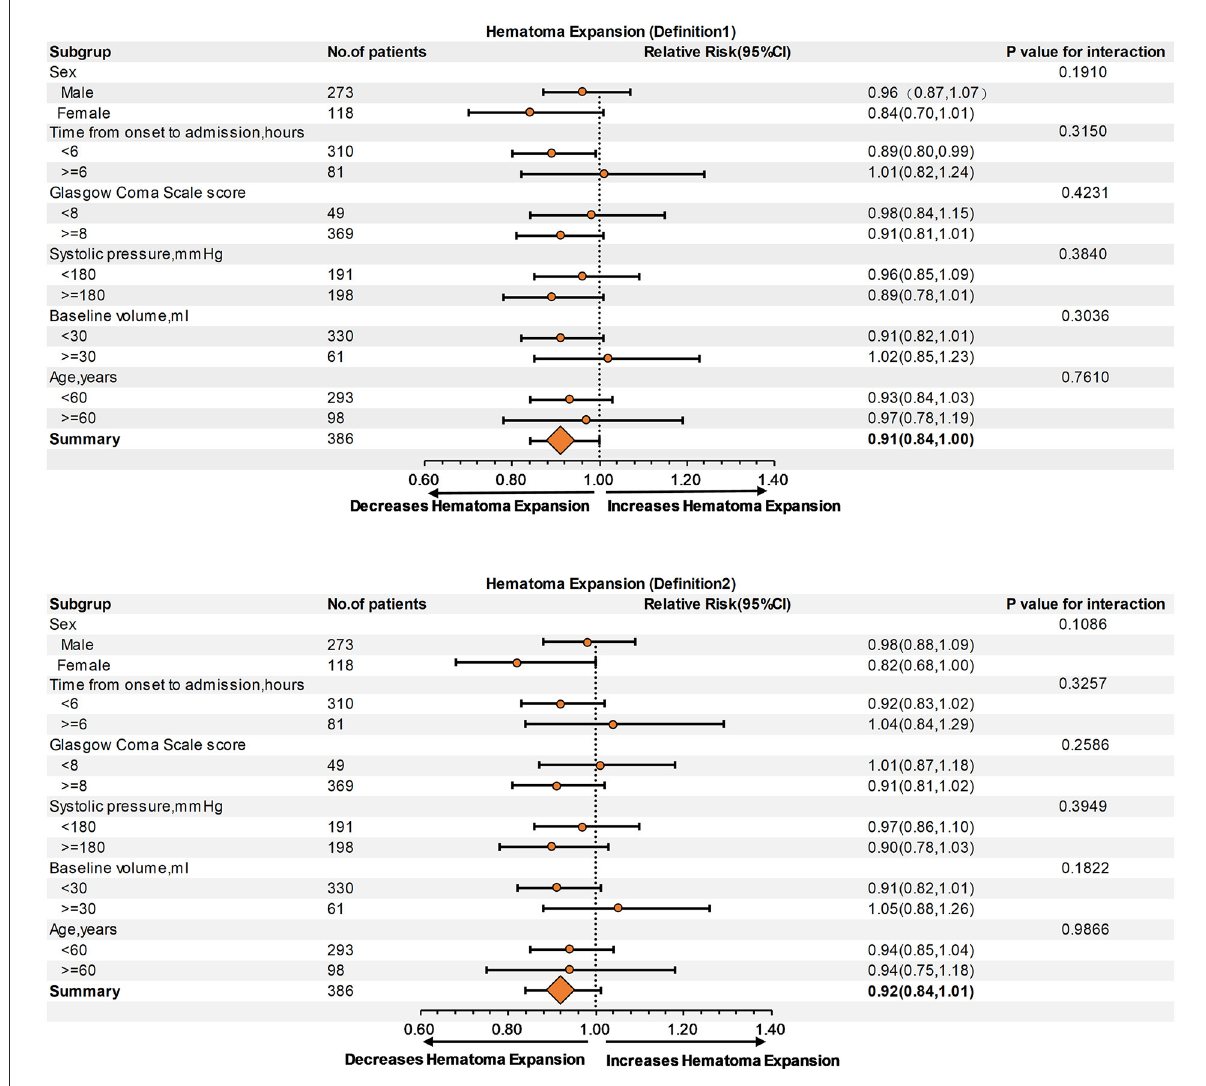
FIGURE4 Subgroup analysis of the relationship of neutrophil count and hematoma expansion (HE) according to Definitions 1 and